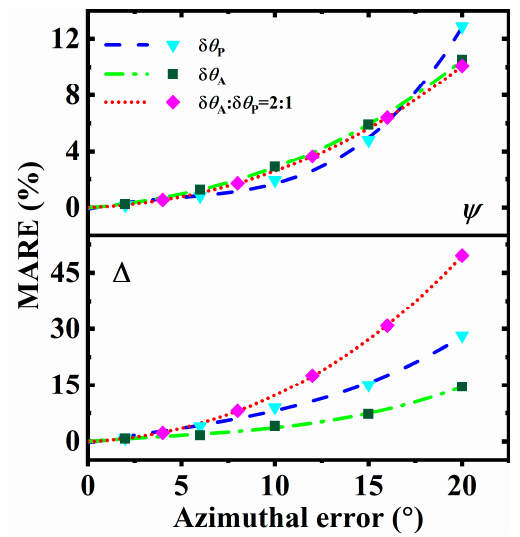
Figure 7. Measured ellipsometric parameters with various azimuthal errors of ( a ) the polarizer, ( b ) analyzer, and ( c ) both at a ratio of 1:2.